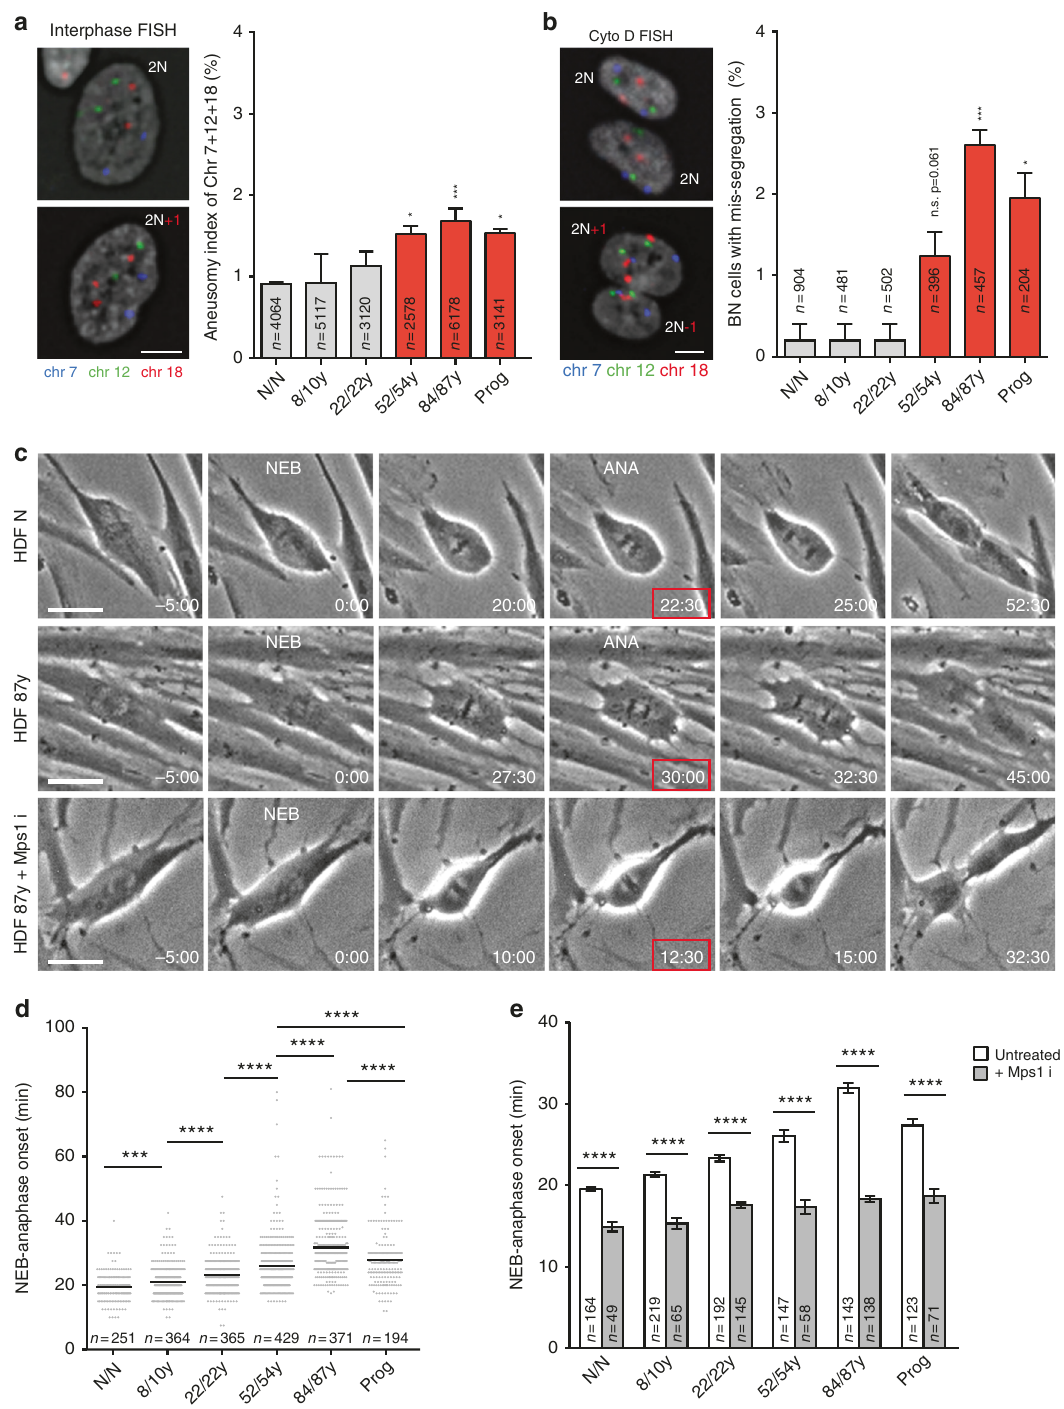
Fig. 1 Aneuploidy and mitotic duration increase during normative aging. a Aneusomy index of three chromosome pairs (7, 12, and 18) in interphase cells from different age donors. b Percentage of cytochalasin D-induced binucleated cells with chromosome 7, 12, and 18 mis-segregation. Representative images of euploid/2N and aneuploid/2N ± l cells are shown in a , b , with chromosome-speci fi c centromeric probes as indicated. Scale bars, 5 µ m. c Frame series of time-lapse phase-contrast movies of mitotic neonatal and elderly cells ± Mps1 inhibitor. Time, min:s. Scale bar, 20 µ m. d Mitotic duration of individual fi broblasts from different donors, measured from nuclear envelope breakdown (NEB) to anaphase onset (ANA). e Mitotic duration under standard conditions as in d (white bars) and following treatment with Mps1 inhibitor (gray bars). Values are mean ± SD from at least three independent experiments, using two biological samples of similar age (except for progeria). Sample size ( n ) is indicated in each graph. NS, p > 0.05, * p ≤ 0.05, ** p ≤ 0.01, *** p ≤ 0.001, and **** p ≤ 0.0001 in comparison with neonatal (N/N) by two-tailed χ 2 ( a , b ) and Mann – Whitney ( d , e ) statistical